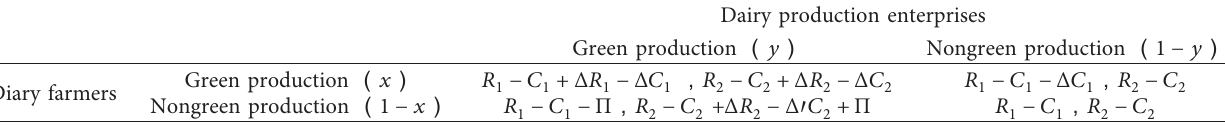
Table 1: Game income matrix of dairy farmers and dairy production